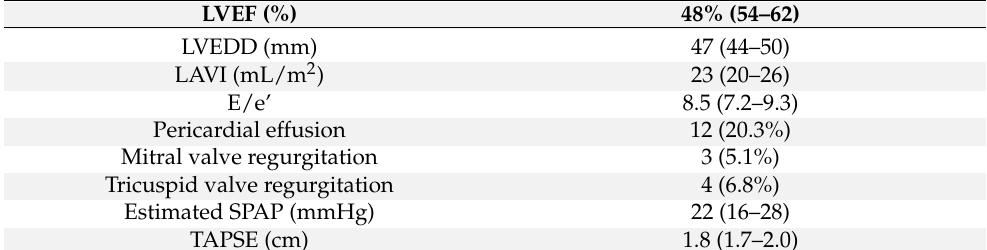
Table 2. Echocardiographic parameters.